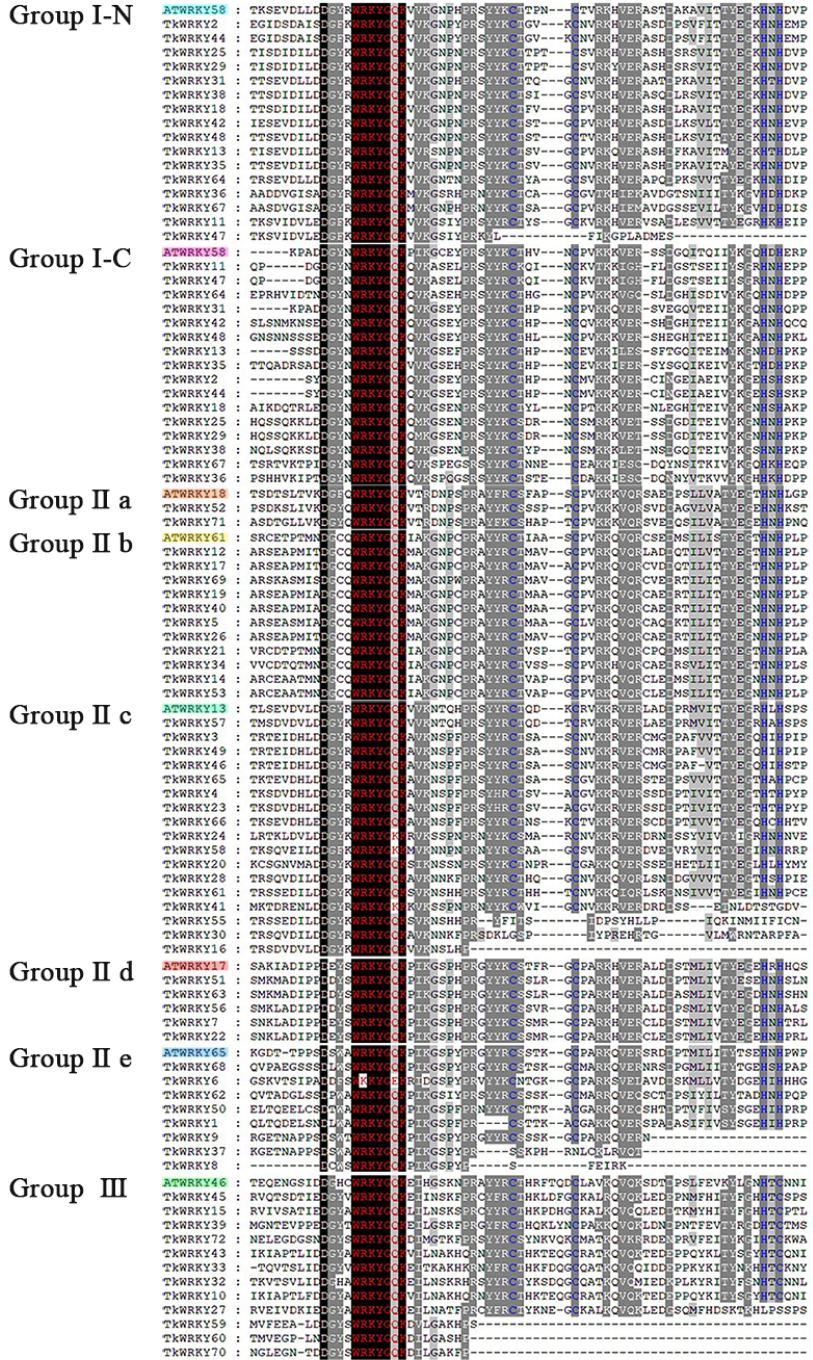
Figure 2. Domain recognition in the TKS WRKY protein sequences. The ATWRKY domain is color-coded.